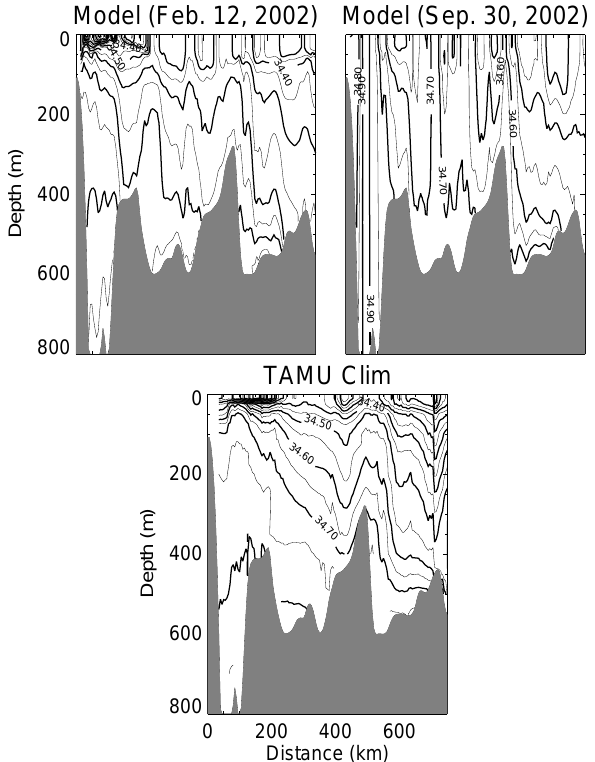
Fig. 2. Model salinity compared to climatological salinity from Orsi and Wiederwohl (2009). The upper two panels are the salinity sec- tion (see Fig. 1) from west to east across the Ross Sea during sum- mer and winter. The lower panel is the climatological salinity from Orsi and Wiederwohl